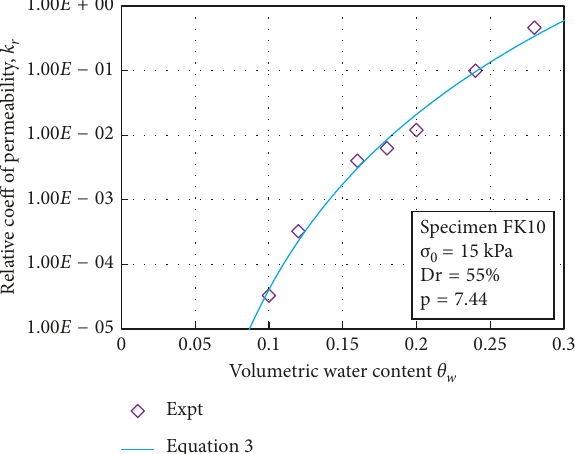
Figure 12: Permeability changes against volumetric water content for FK10